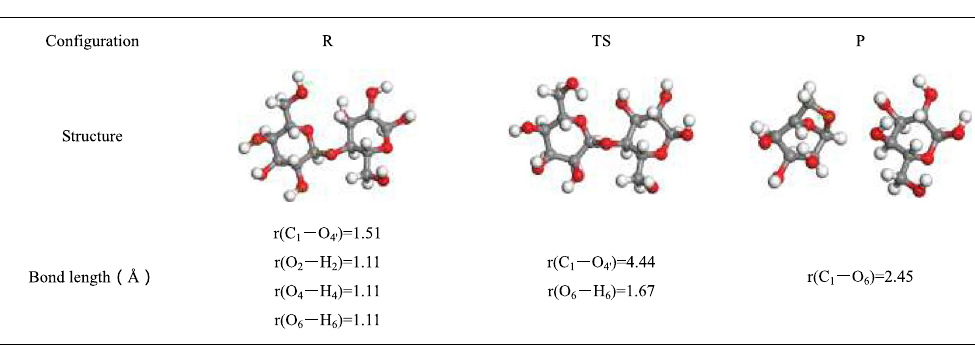
Table 2. Optimized configuration in pathway